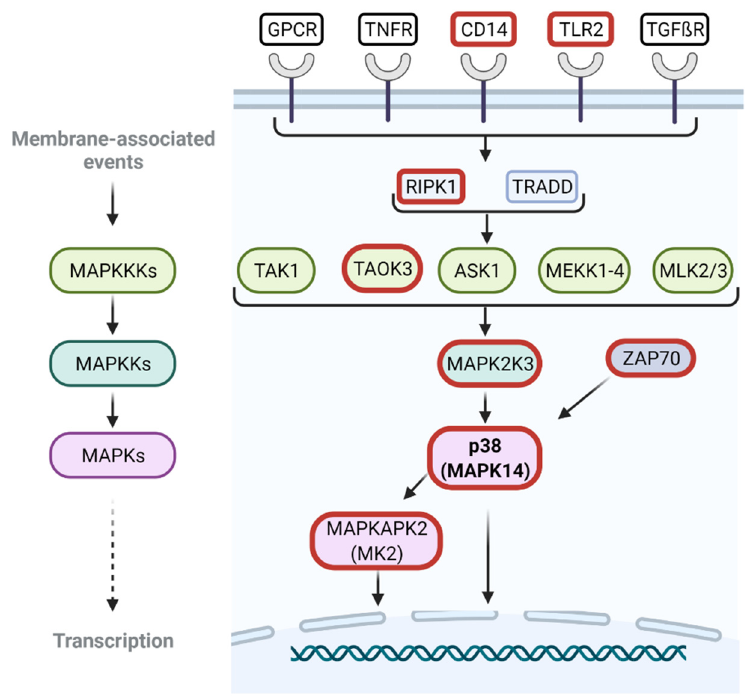
Figure 6. Graphic summary of genes involved in MAPK14/p38a signaling. Genes with decreased expression levels reported in the present study are highlighted by bold red outlines.